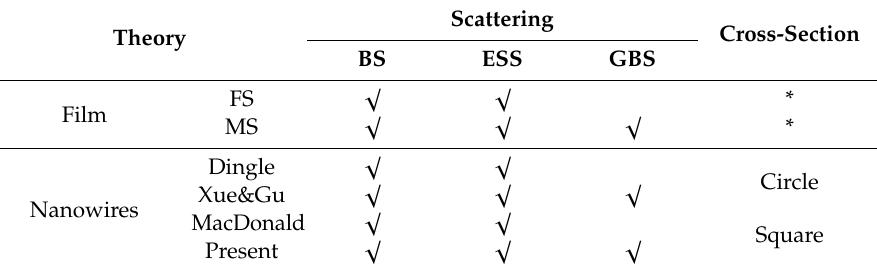
Table 1. Comparison of available models with corresponding scattering mechanism.